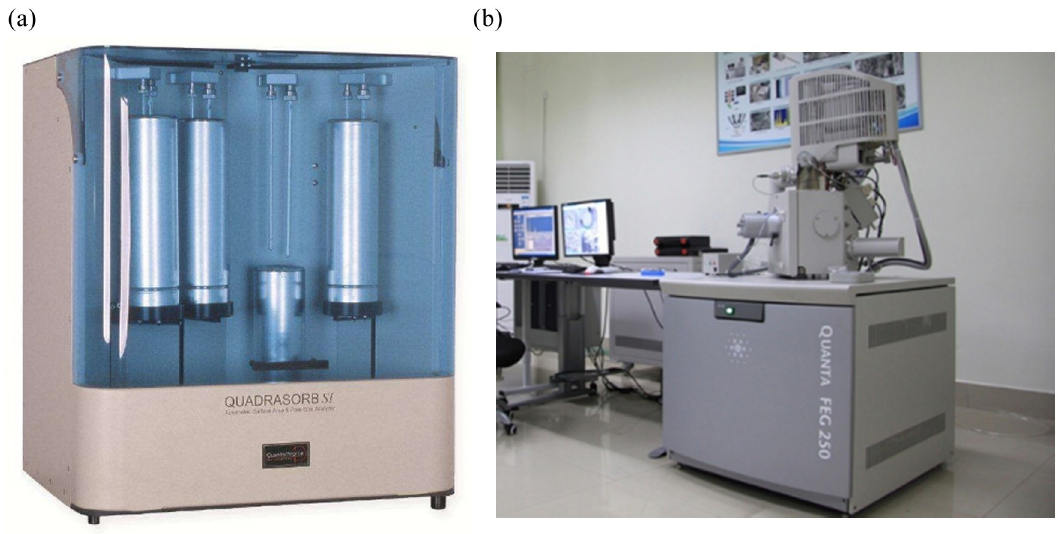
Fig 3. Experimental apparatus for (a) low-pressure nitrogen adsorption and (b) FE-SEM characterization.